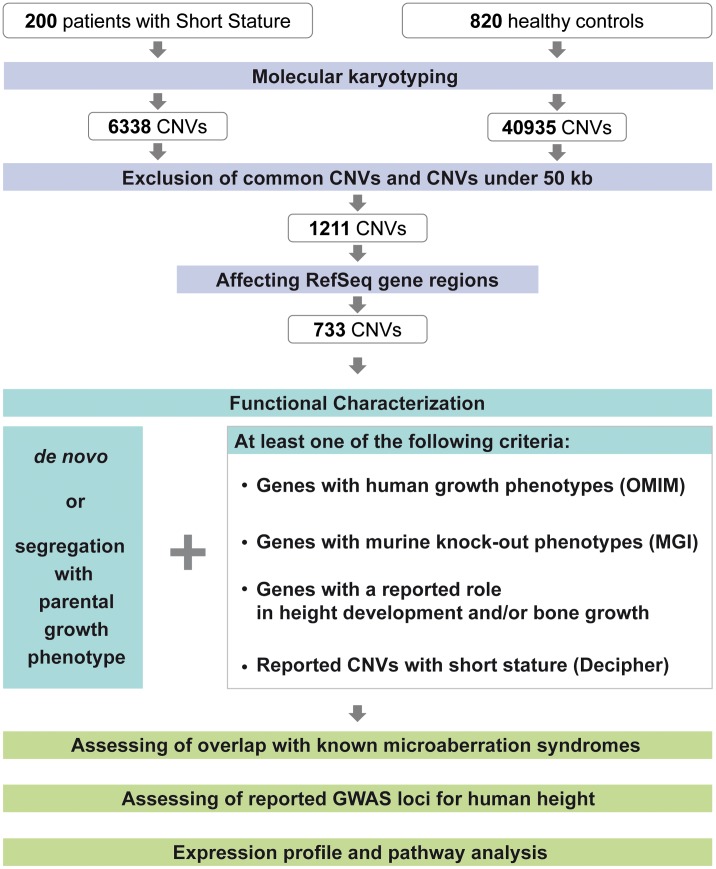
CNV discovery and characterization.Molecular karyotyping was performed for 200 patients with short stature after thorough clinical evaluation and for 820 healthy control samples. Exclusion of common variants using the control samples and scoring CNVs above 50 kb resulted in an approx. reduction of 80% of the CNVs identified in the patient samples. 60.5% of these CNVs affect reference sequence gene regions. Functional characterization includes segregation analysis using parental arrays and/or MLPA as well as gene and CNV based evaluation.